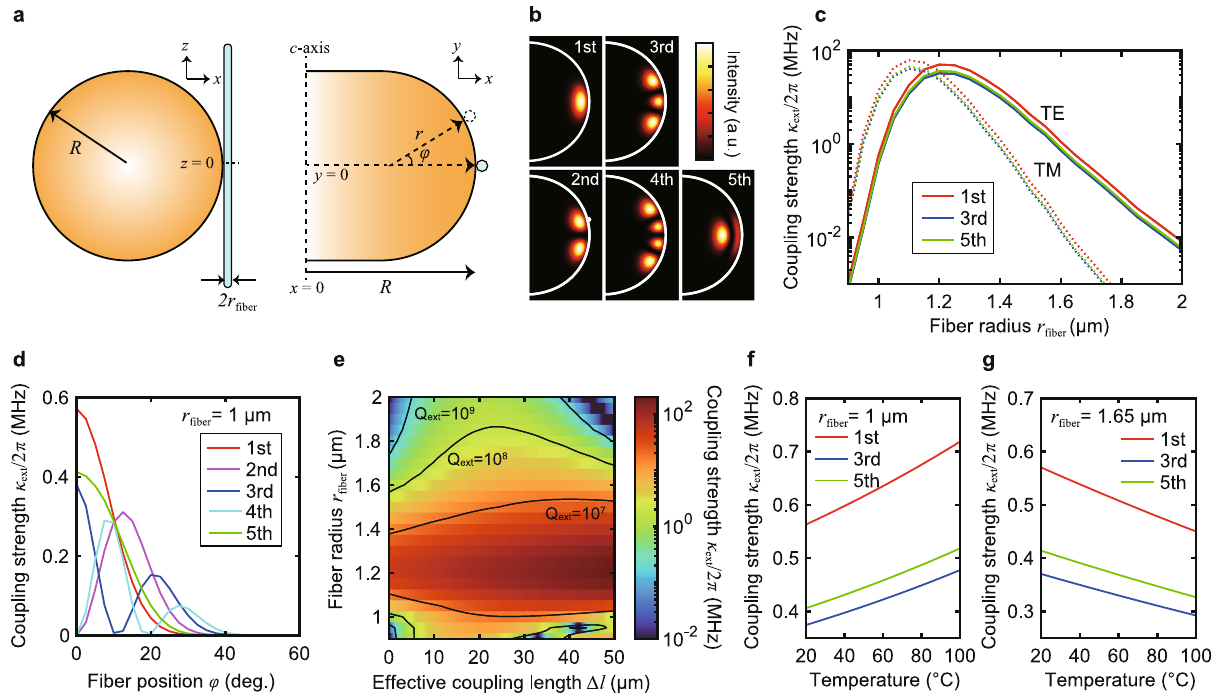
Fig. 4 Analysis of the coupling strength in a crystalline MgF 2 microresonator coupled to a silica tapered fi ber. a Schematics of the fi ber-resonator coupling model in x – y – z coordinates, where R and r correspond to a resonator radius and curvature, respectively. The fi ber position along the curvature is given by the polar angle φ . b Mode pro fi les of several whispering-gallery (WG) modes. The fundamental mode is designated as 1st and the higher-order modes are named sequentially. The color bar shows the electric fi eld intensity. c Simulated coupling strength versus fi ber radius for three WG modes. The fi ber radius showing the maximum coupling strength modes is shifted literally due to the difference between refractive indices of the transverse-electric (TE) and transverse-magnetic (TM) modes. d Coupling strength as a function of fi ber position φ for the TE modes. e Contour map of coupling strength showing the dependence on fi ber radius and effective coupling length Δ l for the TE 1st mode. The color bar shows the coupling strength κ ext /2 π in units of MHz. Coupling strength as a function of temperature for the 1st, 3rd, and 5th TE modes at different fi ber radii, f for r taper = 1 μ m and g for r taper = 1.65 μ m. The temperature-dependent refractive index change modi fi es the phase-matching condition, resulting in increased or reduced coupling